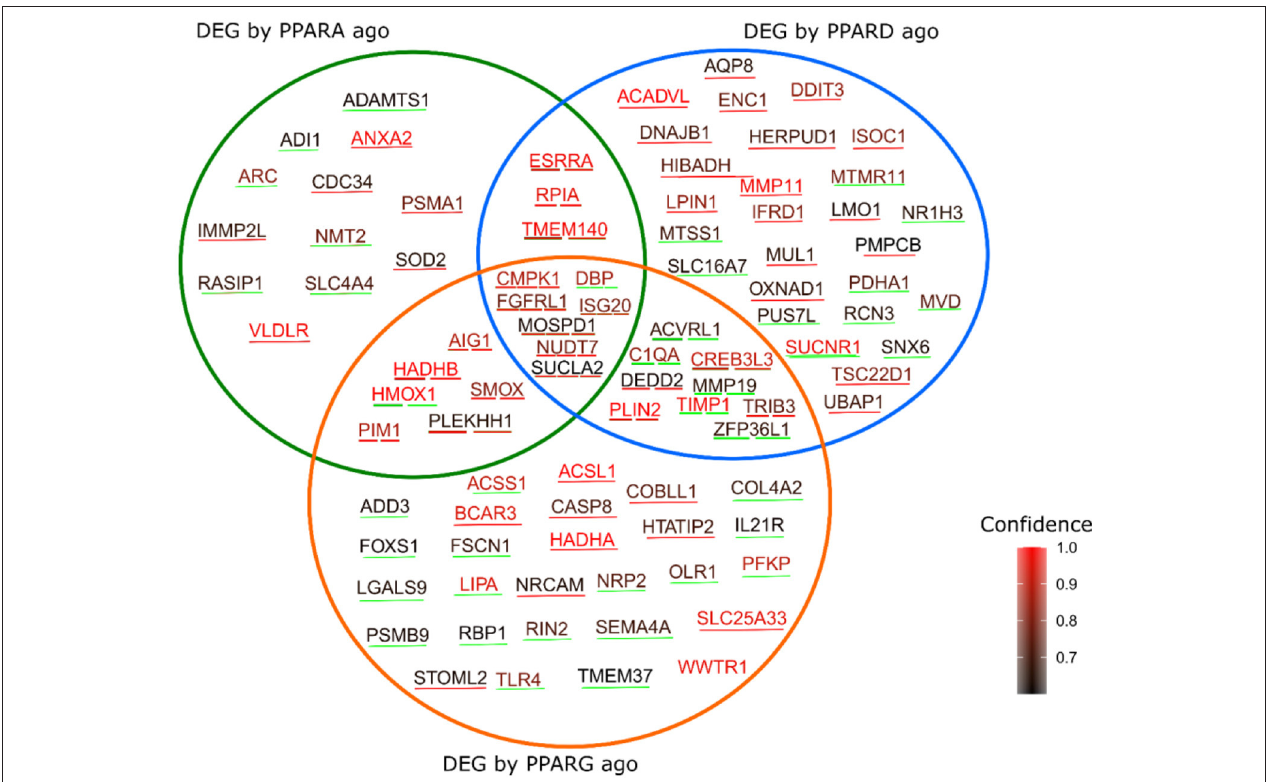
FIGURE 7 | Genes predicted as PPAR target by the PPARgene algorithm, which were also differentially expressed by the three treatments in the current study. The color of the words corresponds to the degree of confidence of the prediction, while the color of the underlining line indicates the direction of the differential expression, with red indicating upregulation in response to the treatment, and green indicating downregulation.